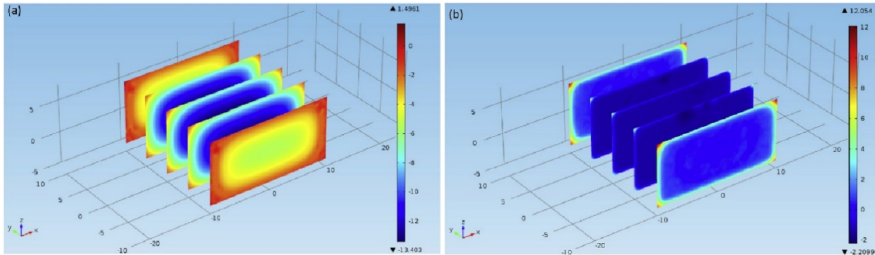
Figure 2. Contour plot showing the temperature distribution of the lean beef at a radio frequency of 50 Ω and thawing times of ( a ) 600 s and ( b ) 3000 s. Reproduced from Uyar et al. [118] with permission from Elsevier,